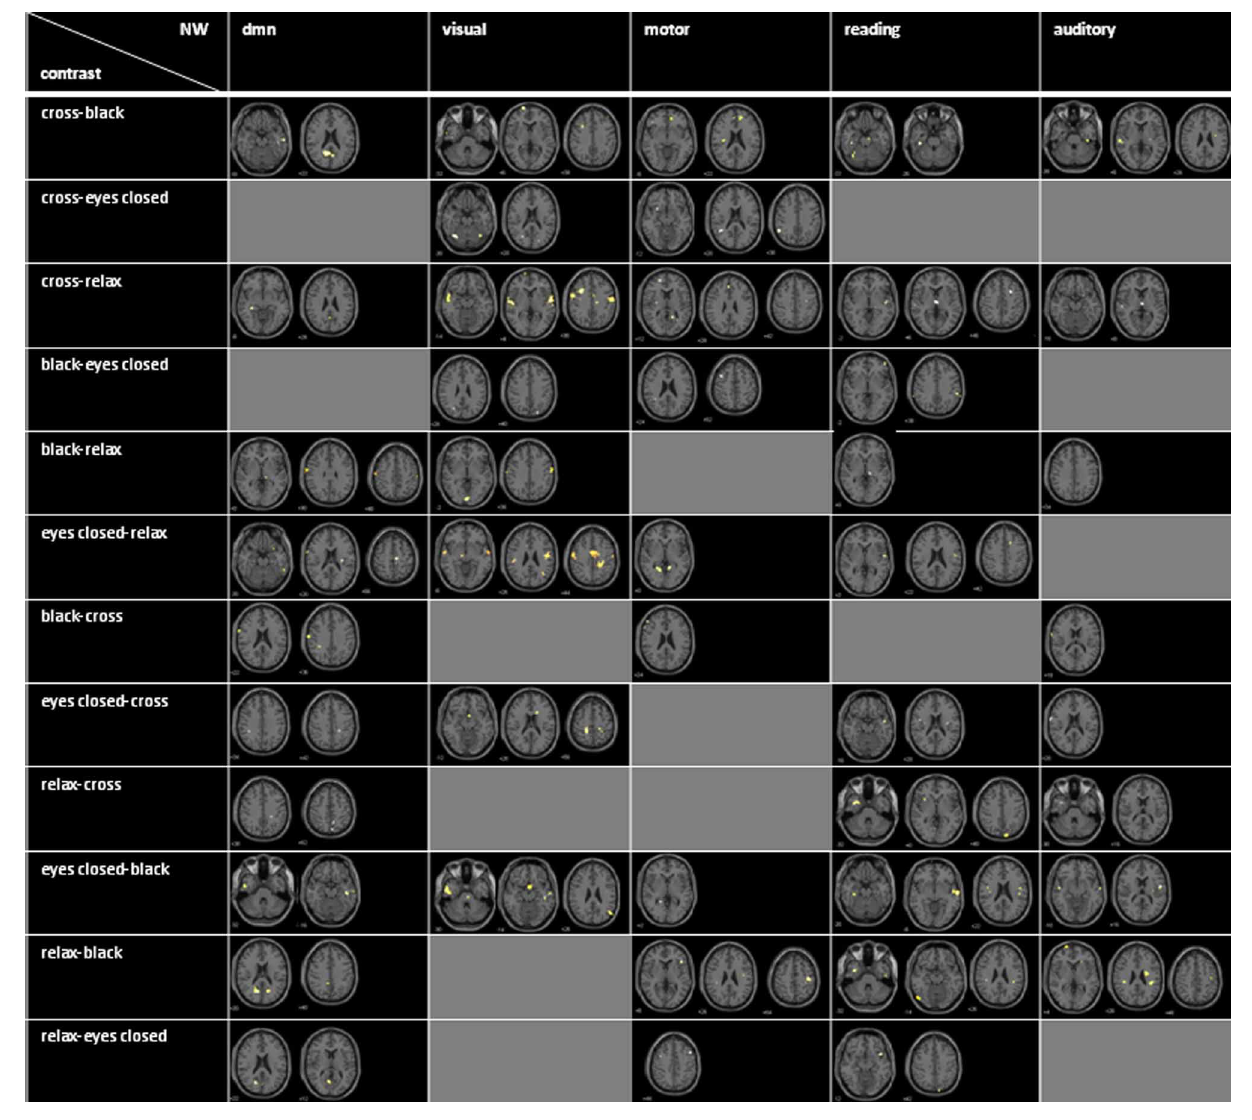
FIGURE A1 | Axial mean anatomical images overlaid by brain activation resulting from contrasts for all conditions and networks ( p < 0 . 001 uncorrected for whole-brain volume